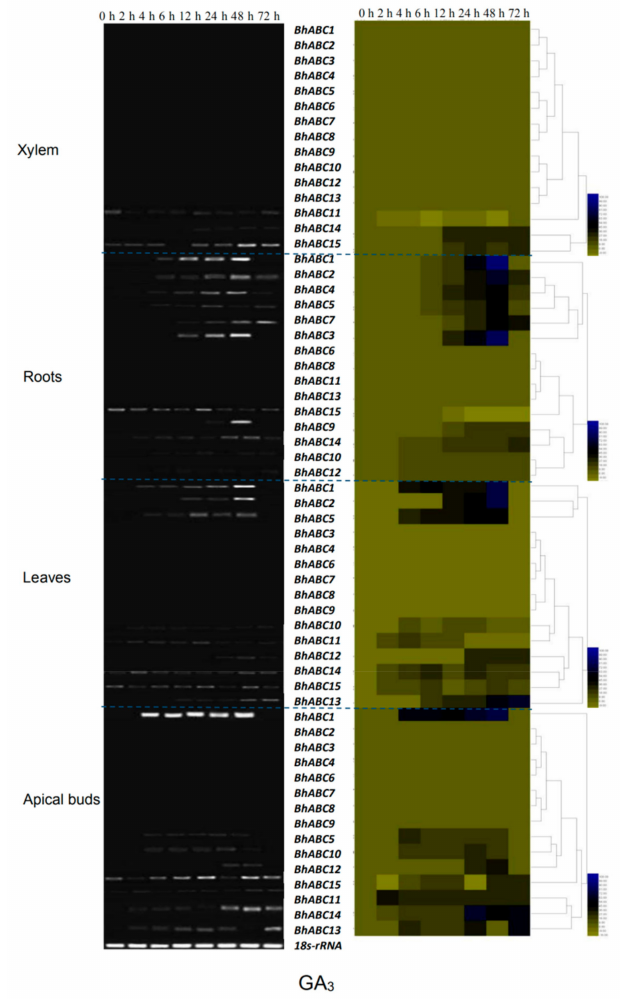
Figure 5. Expression patterns of BhABC genes in xylem, roots, leaves, and apical buds after GA 3 treatment. Heat map showing responses of BhABC genes to GA 3 (right); semi-quantitative RT-PCR analysis with 18s RNA internal reference